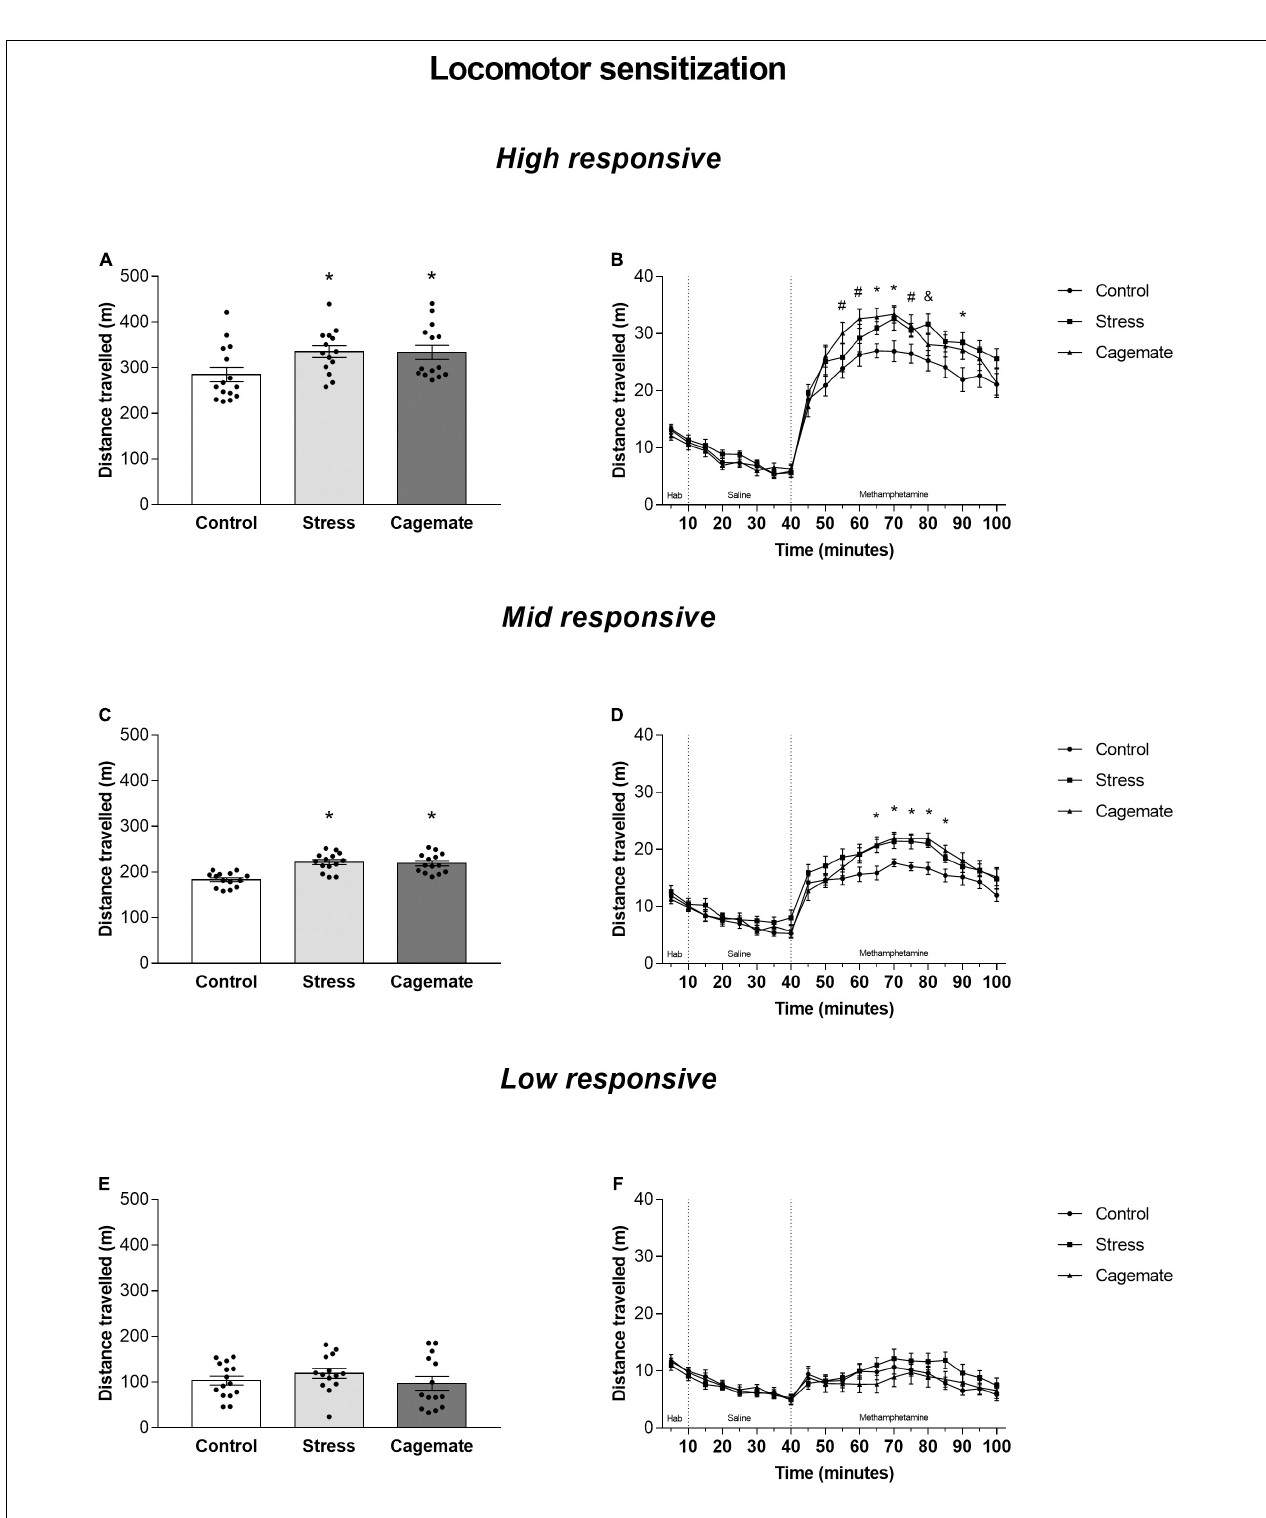
FIGURE 3 | All data are presented as mean ± SEM. (A) Total distance traveled during 60 min test by high responsive mice after methamphetamine challenge (1.5 mg/Kg) ( n = 14–15 per group); (B) distance traveled by high responsive mice during each 5-min block during habituation, saline challenge (1 mL/Kg), and methamphetamine challenge (1.5 mg/Kg) ( n = 14–15 per group); (C) Total distance traveled during 60 min test by mid responsive mice after methamphetamine challenge (1.5 mg/Kg) ( n = 14 per group); (D) distance traveled by mid responsive mice during each 5 min block during habituation, saline challenge (1 mL/Kg), and methamphetamine challenge (1.5 mg/Kg) ( n = 14 per group); (E) total distance traveled during 60 min test by low responsive mice after methamphetamine challenge